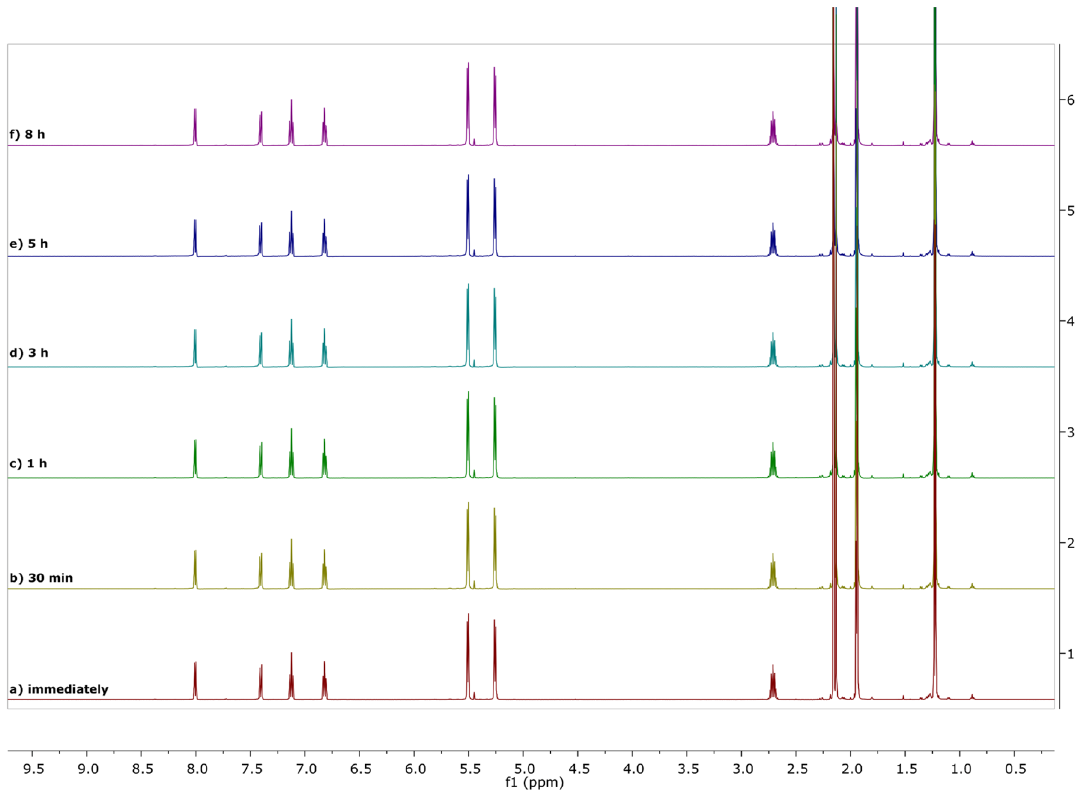
Figure 10. Spectra of Ru-Pth in acetonitrile-d 3 followed by 1 H NMR spectroscopy at different time